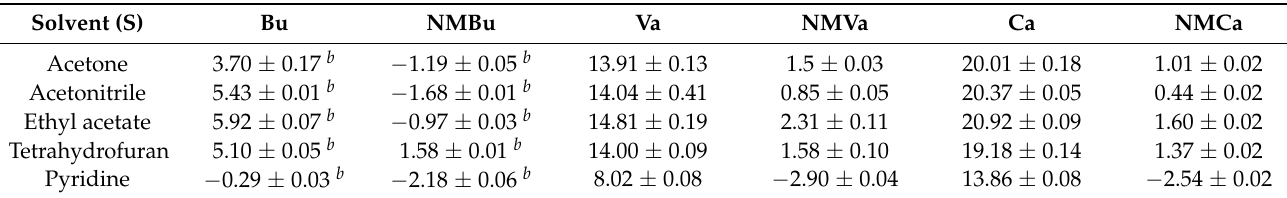
Table 1. Solution enthalpies of γ -butyrolactam (Bu), N -methylbutyrolactam (NMBu), δ -valerolactam, (Va), N - methylvalerolactam (NMVa) and ε -caprolactam (Ca), N -methylcaprolactam (NMCa) in proton acceptor solvents, (kJ · mol − 1 , T = 298.15 K , P = 0.1 MPa) a .